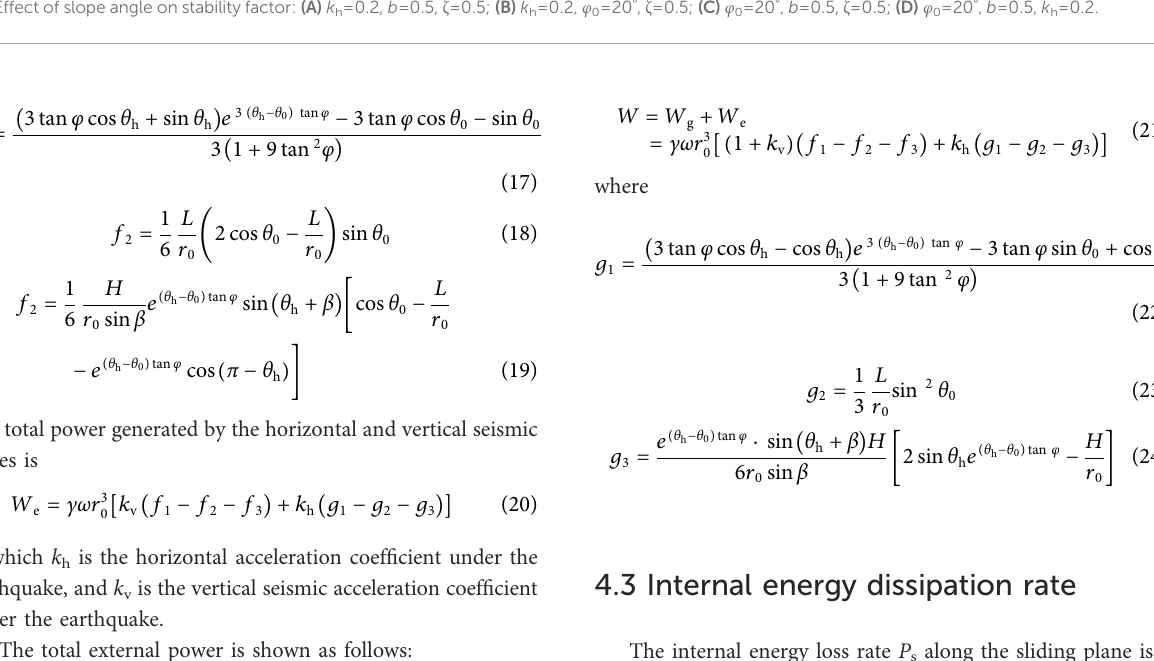
Frontiers in Earth